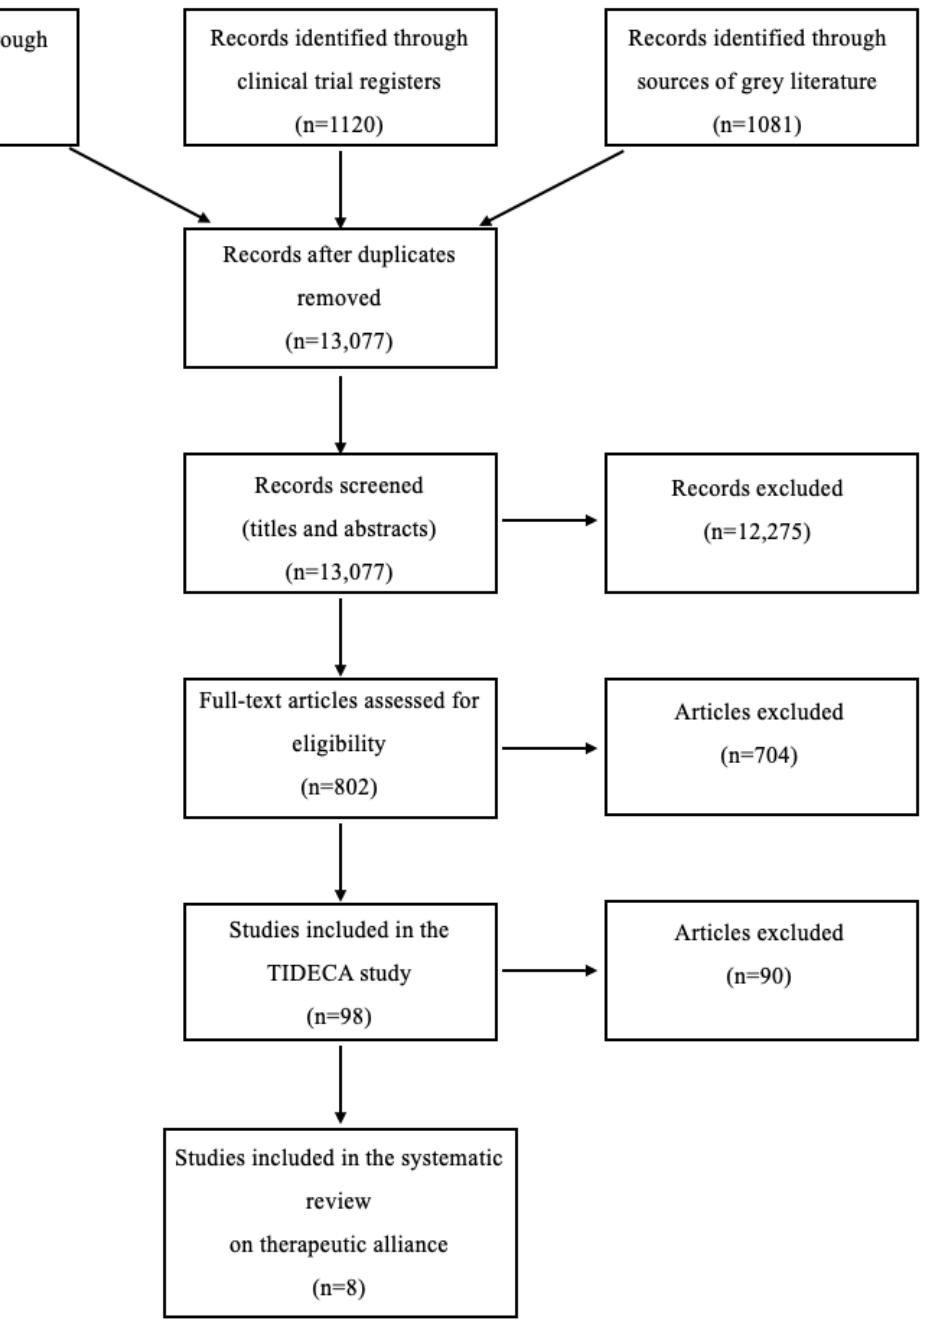
Figure 1. PRISMA flow diagram. TIDECA: Technology-based Interventions in different steps of Depression